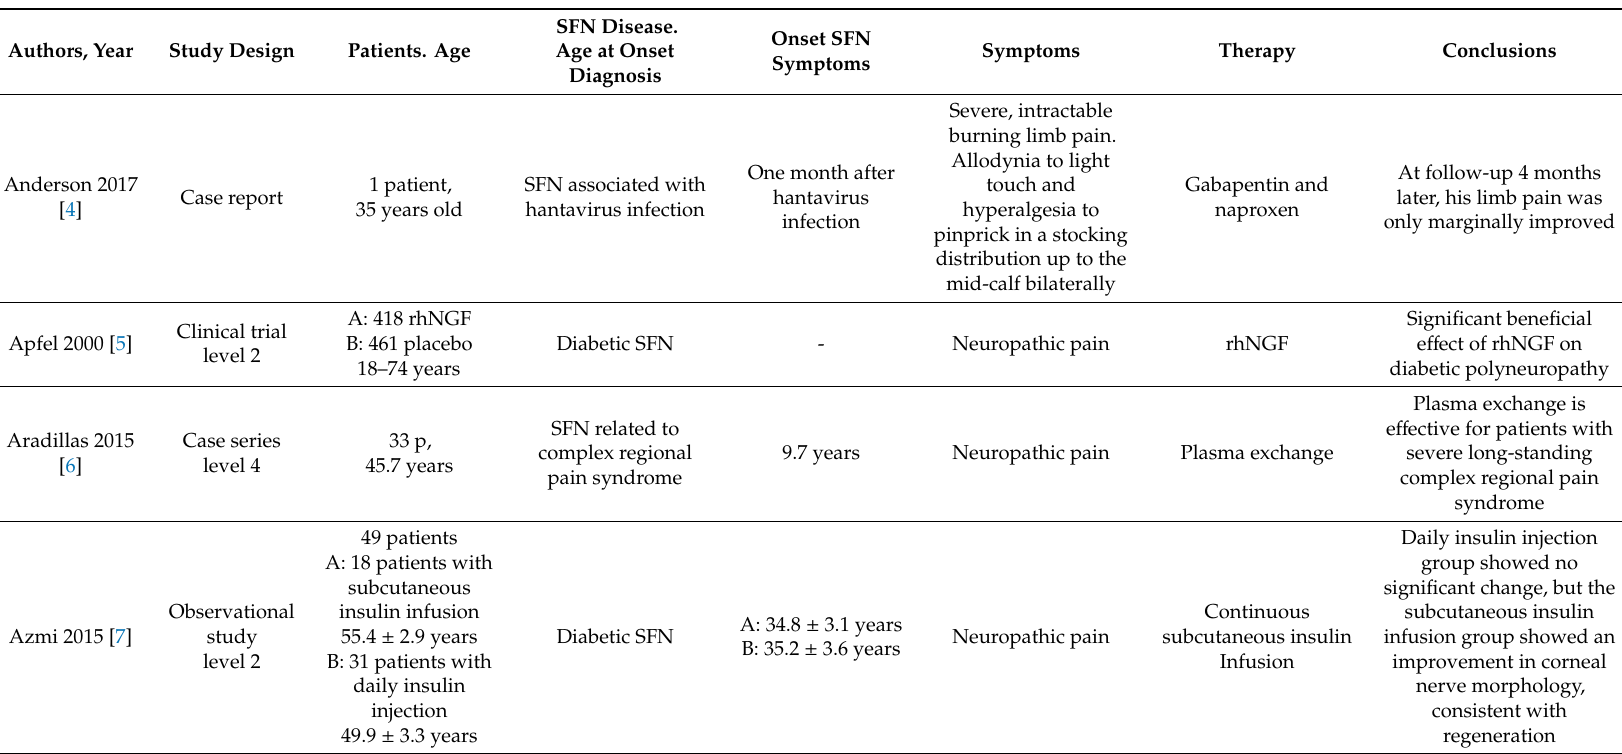
Table 1. Treatment of SFN. Characteristics and outcomes of studies included in the systematic